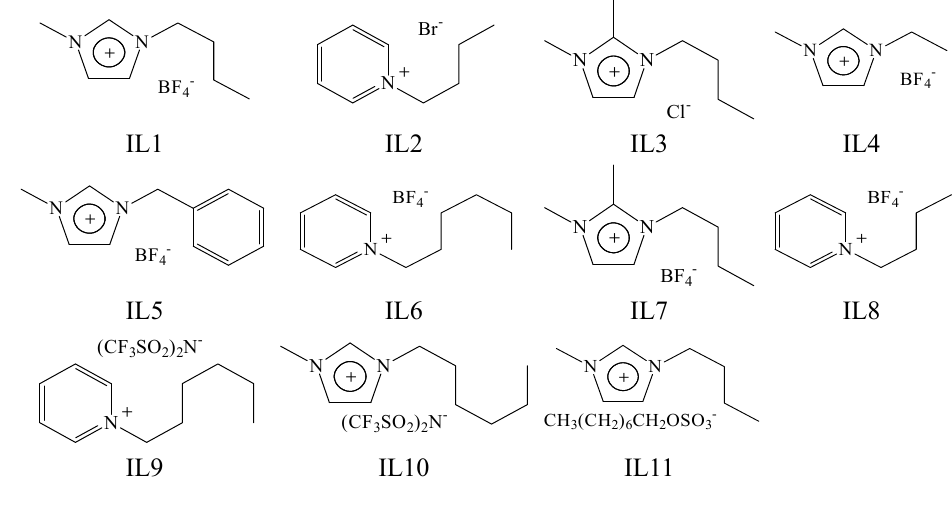
Figure 3. Chemical structure of the test ionic